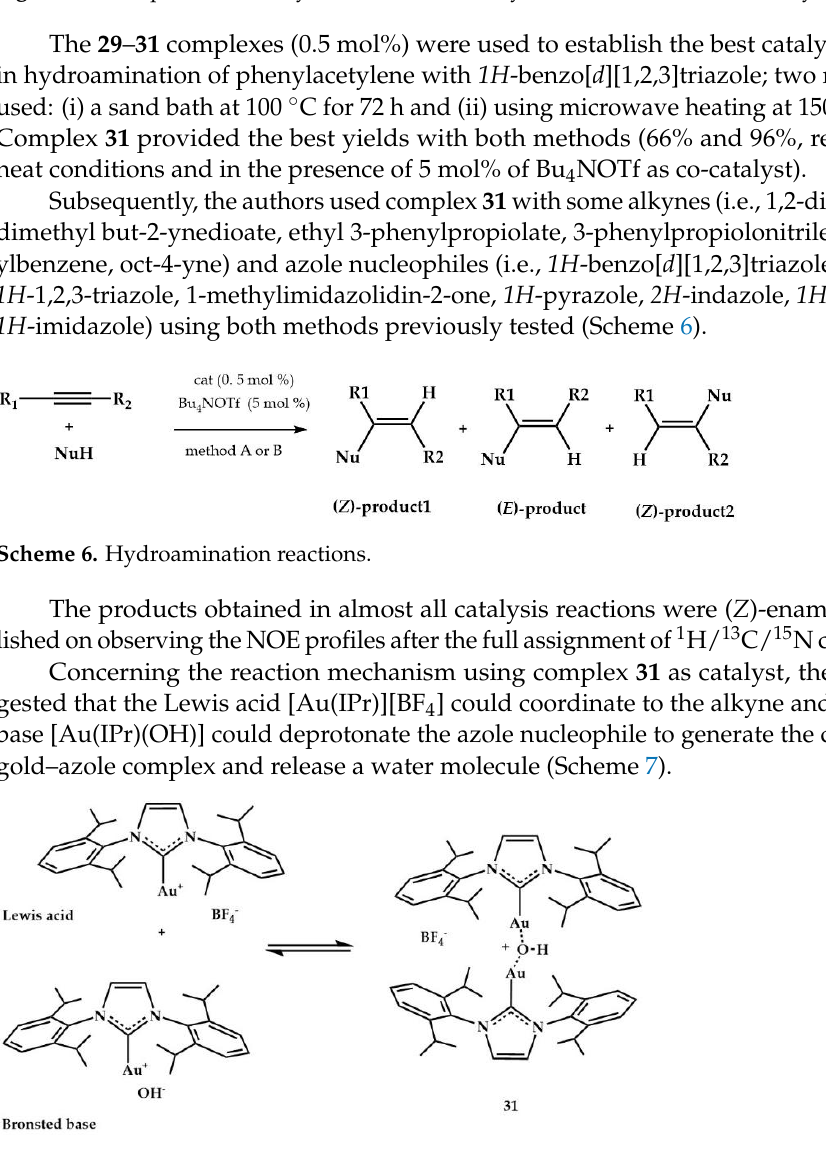
Figure 14 . Complexes tested by Nolan et al. in the hydroamination of internal alkynes.